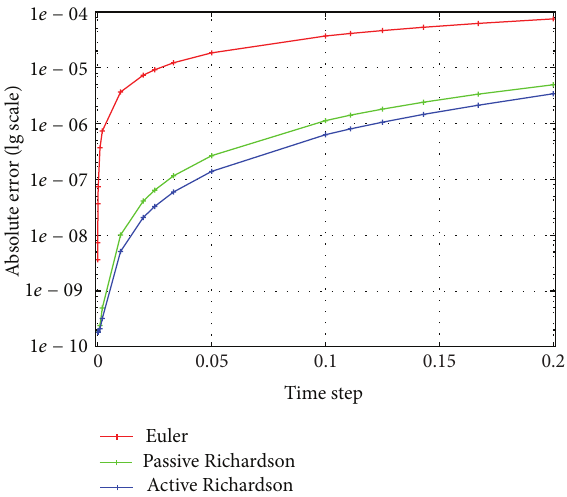
Figure 5: Absolute error as a function of time step in case of a quadratic reaction term for the Euler method without and with passive and active Richardson extrapolation, by grid step Δ𝑥 = 1 and coefficient 𝐷 = 1.0 . The reference solution was calculated using Δ𝑡 = 10 −7